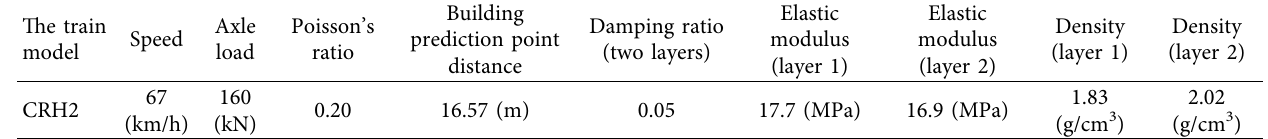
Table 3: The values of